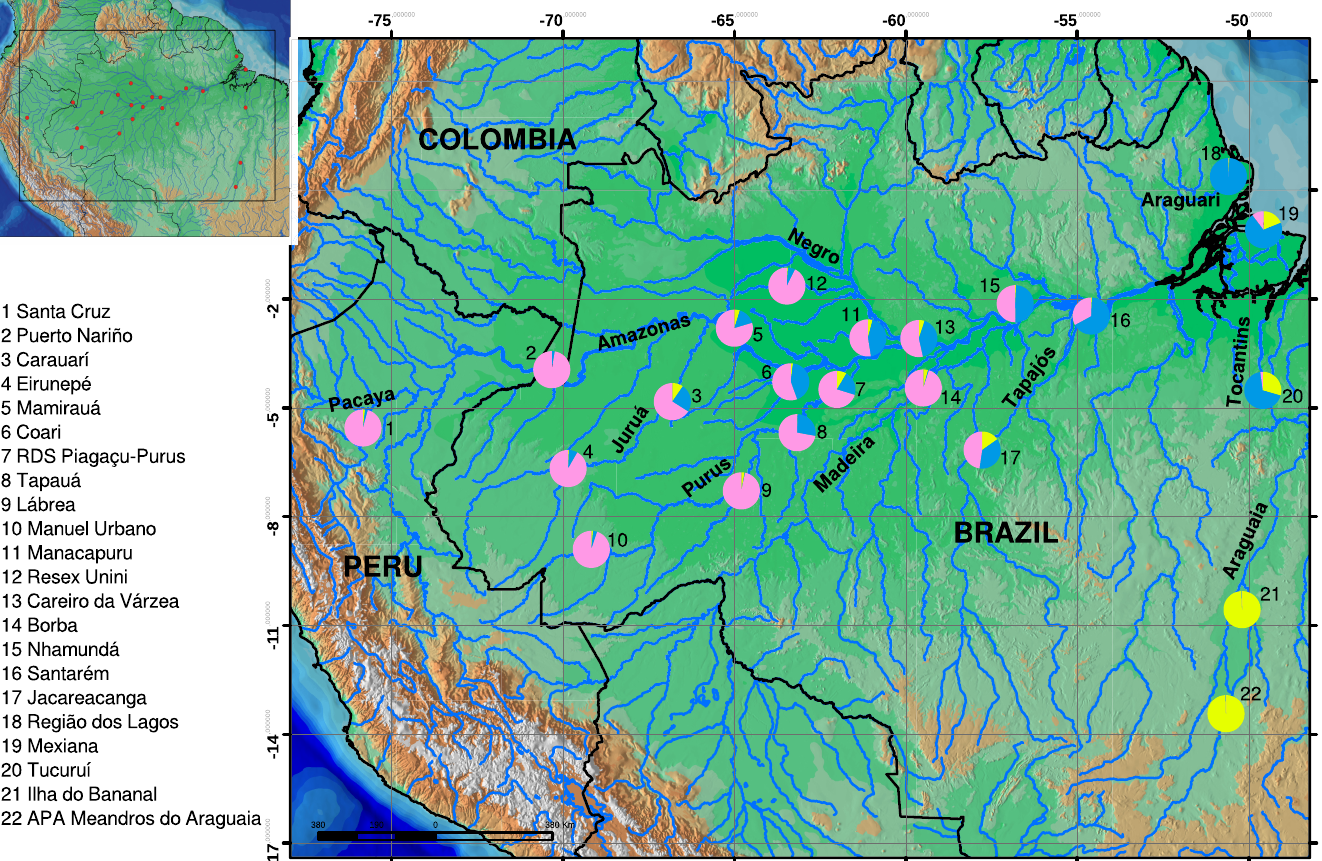
Fig 1. Map of collecting localities of Arapaima gigas . Pie plots indicate average population ancestry of each of the three main biological clusters detected in STRUCTURE analysis (see Fig 2). Color scheme is same as in Fig 2, K = 3.